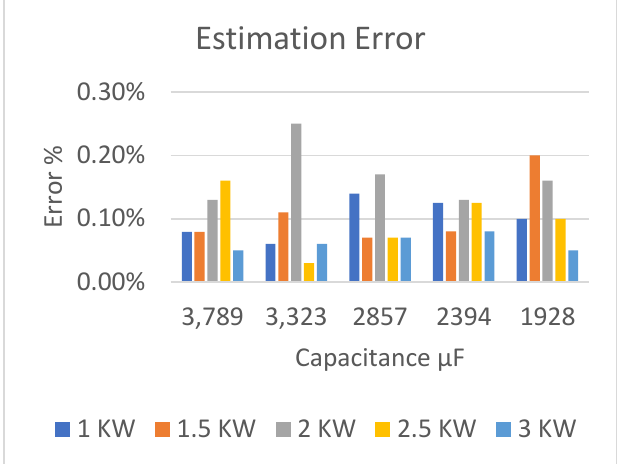
Figure 8. Capacitance estimation at abrupt variation of C using SVR.